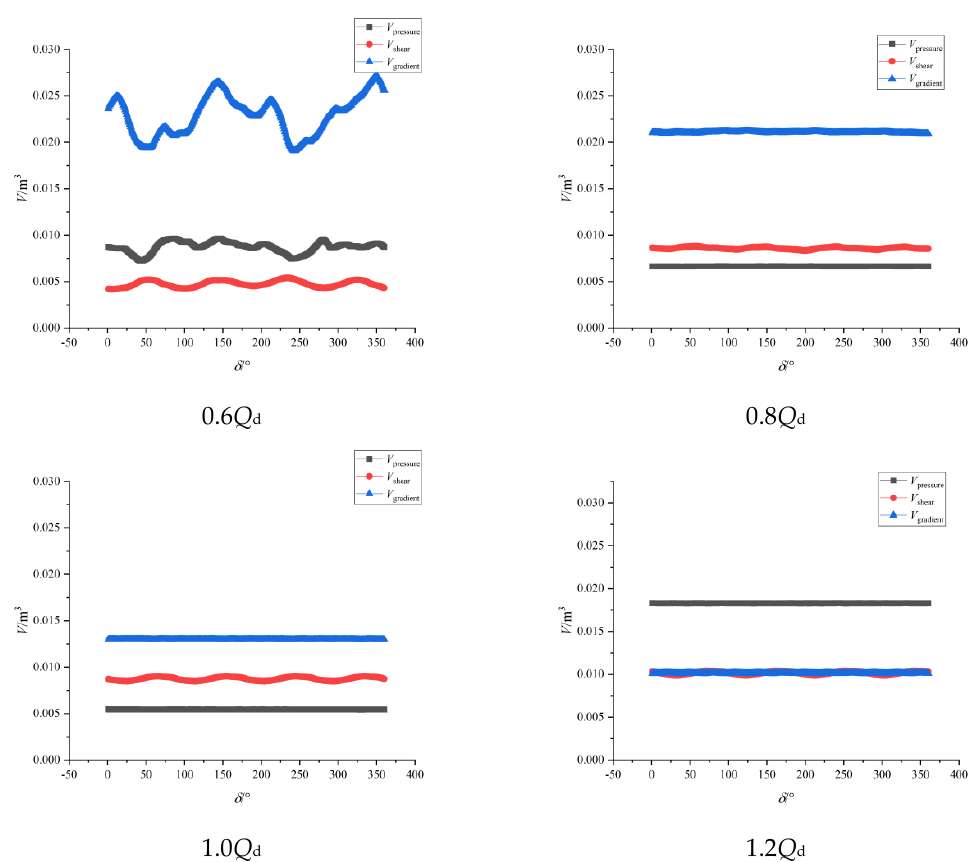
Figure 11. Variation diagram of damage source area in impeller with time at different flow rates.